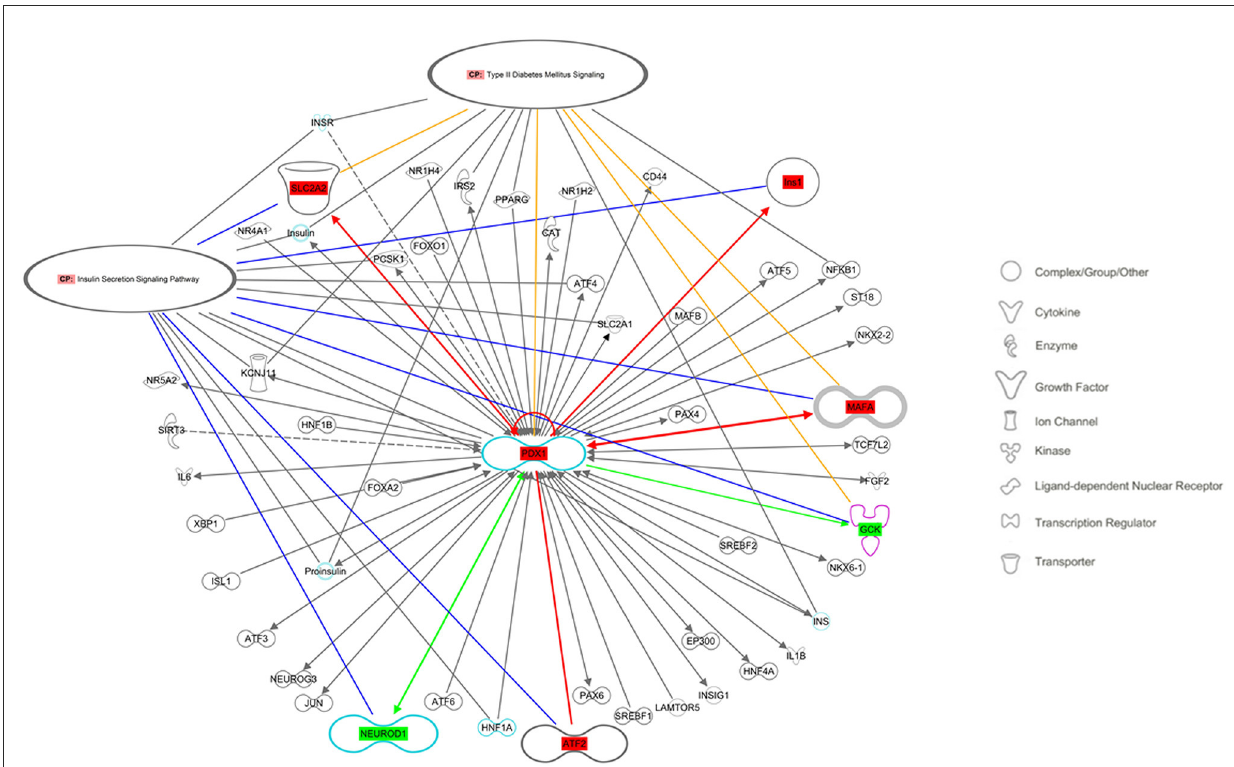
FIGURE5 Regulatory networks related to the insulin secretion signaling pathway and type 2 diabetes mellitus signaling, as predicted by QIAGEN’s Ingenuity Pathway Analysis considering the studied genes: Ins , Insulin; Slc2a2 , Solute carrier family 2 member 2 (also known as Glut2 ); Gck , Glucokinase; Pdx1 , Pancreatic and duodenal homeobox 1; MafA , Musculoaponeurotic fibrosarcoma oncogene family A; Atf2, Activating transcription factor 2; NeuroD1 , Neuronal differentiation 1. Molecules in the pathway showed in red had increased gene expression, whereas those in green had decreased gene expression. Solid lines indicate direct interactions between factors. Yellow lines indicate the participants in the canonical route of type 2 diabetes mellitus signaling, and blue lines indicate the insulin secretion signaling pathway.